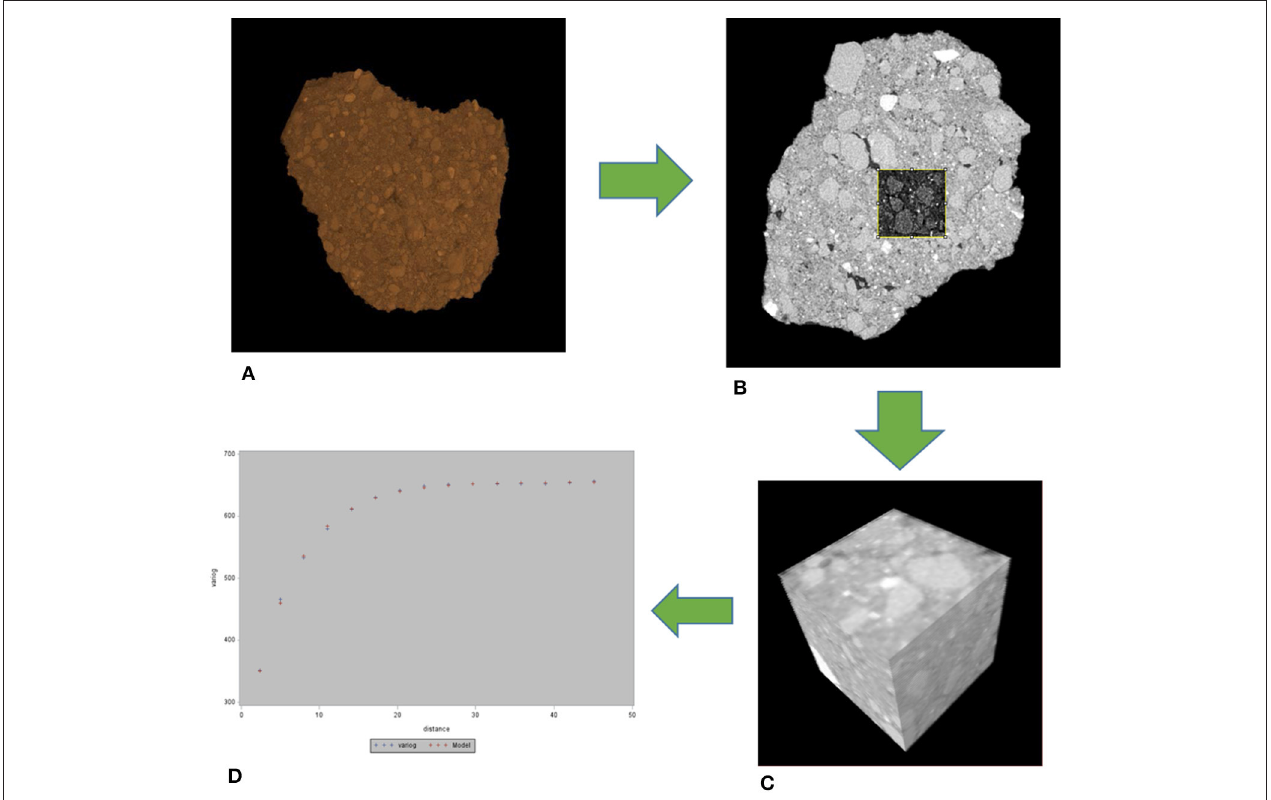
FIGURE 1 | Workflow for the geostatistical analysis. From each whole aggregate (A) , 5 cubes were selected (B , C) and then a 3D variogram obtained (D) . The whole aggregate is 5mm in size, while the cubes in the slice (B) and 3D (C) are 130 µ m on a side.